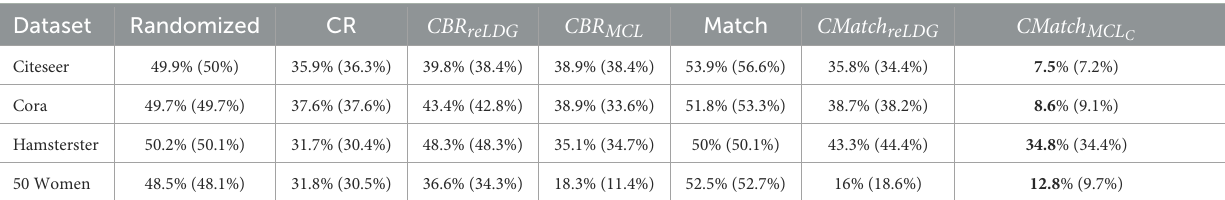
TABLE 2 Percentage of edges (and edge weights) between treatment and control nodes. Dataset